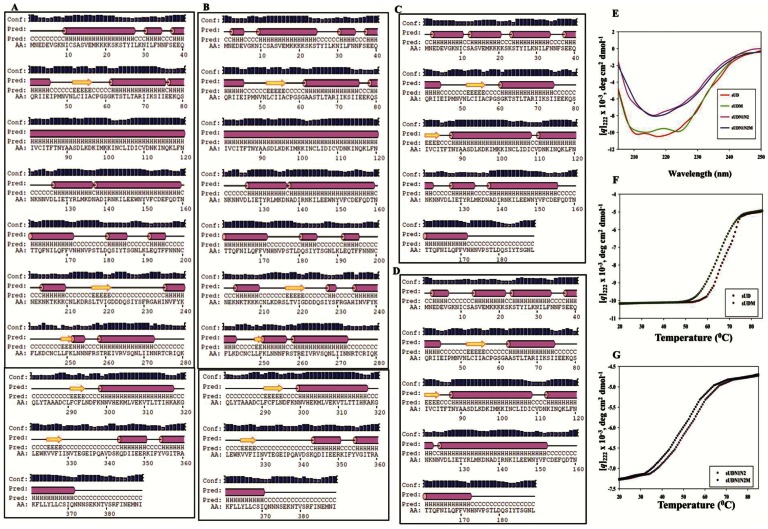
A–D. Secondary structure representation. The protein sequences of sUD, sUDM, sUDN1N2 and sUDN1N2M were submitted to the server at http://bioinf.cs.ucl.ac.uk/psipred/and the secondary structures were determined. The graphs in A–D represent the structures of sUD, sUDM, sUDN1N2 and sUDN1N2M, respectively. E. Circular dichroism (CD) spectra of sUD, sUDM, sUDN1N2 and sUDN1N2M. F-G. CD spectra of sUD and sUDM, and sUDN1N2 and sUDN1N2M, respectively at different temperature.